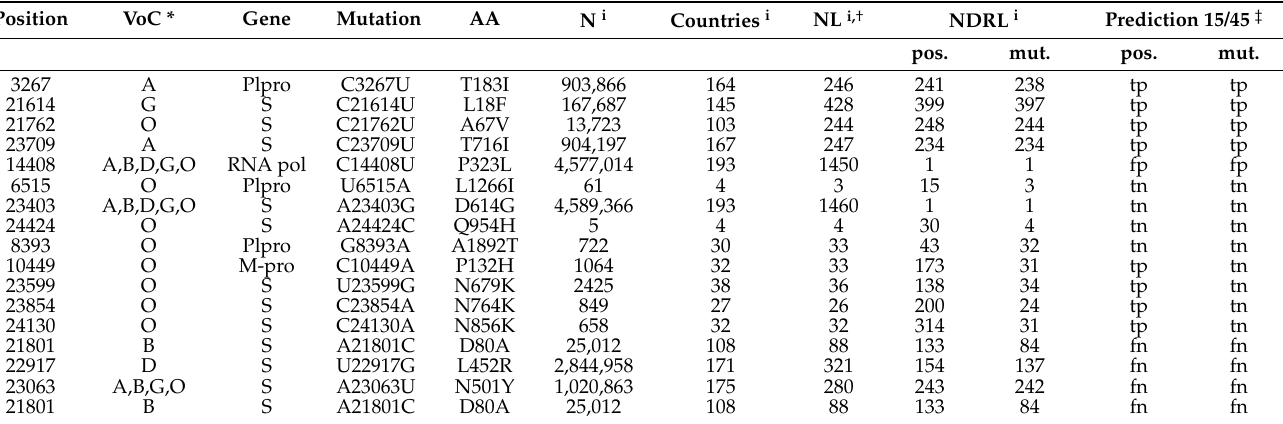
Table 3. Summary of some VoC predictions on position (pos) and mutation (mut). See Table S1 for a complete table.